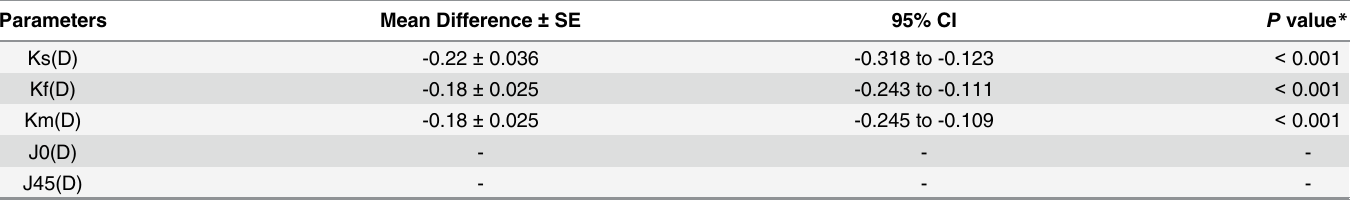
Table 7. Comparison of Ks, Kf and Km obtained by Topcon KR-1W and IOLMaster. (Note: Ks: steep keratometry, Kf: flat keratometry, Km: mean kerato- metry, D: diopter, SD: standard Error, 95% CI: 95% consistent interval, * Bonferroni corrected.)